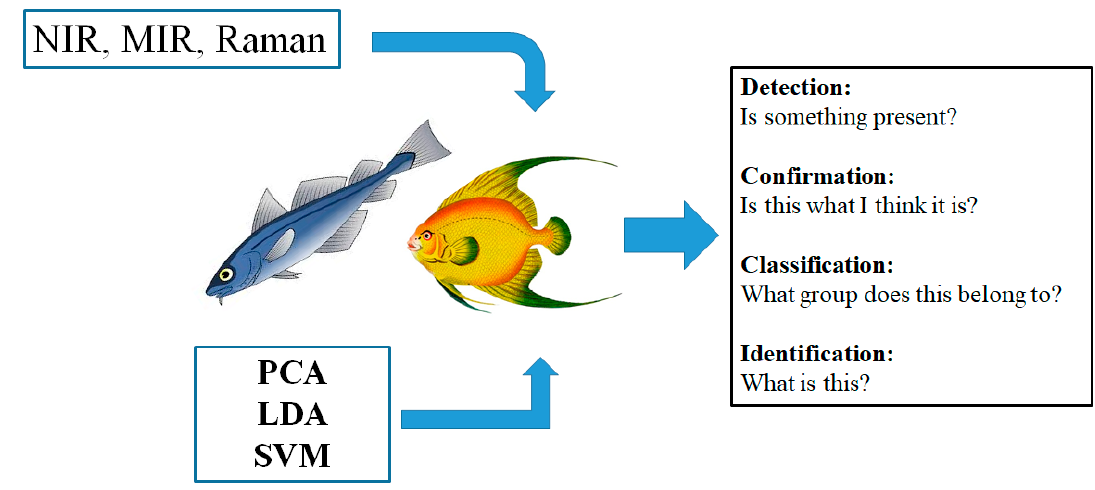
Figure 2. Fish and seafood authenticity, traceability and provenance. The combination of chemometrics and vibrational spectroscopy. What is the right question to ask?